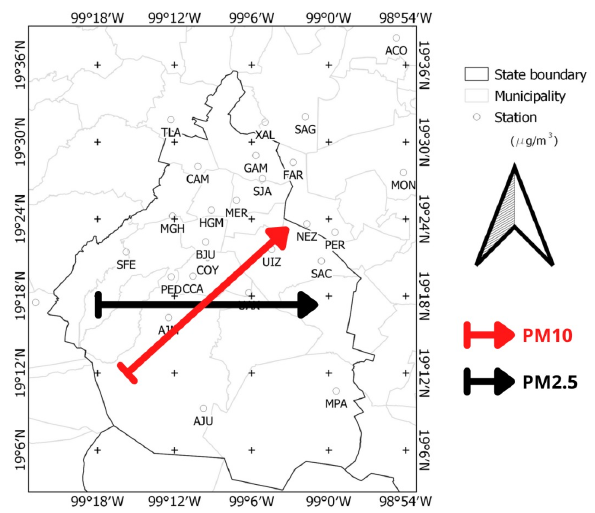
Figure 8. Spatial comparison of increase trends in the study region. PM10 (red line, Aguirre-Salado et al. [12]) and PM2.5 (black